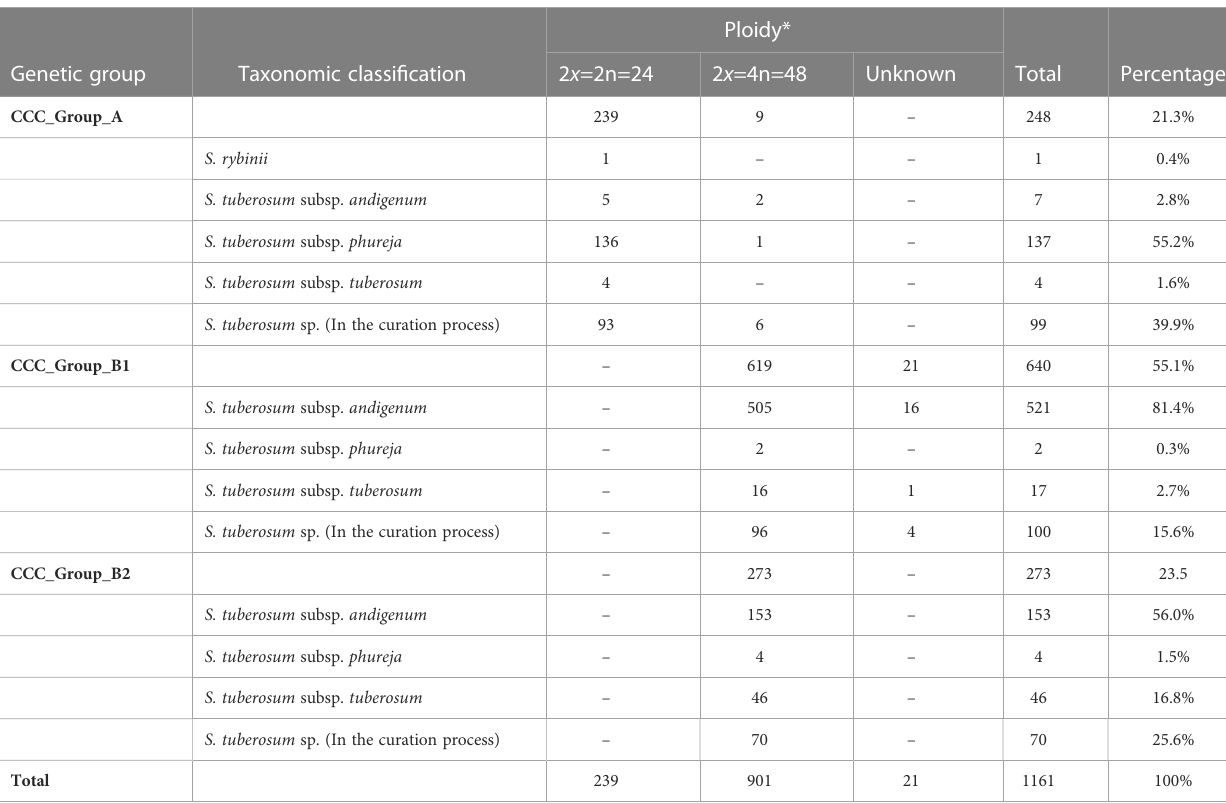
TABLE 2 Taxonomic and ploidy characteristics of three genetic groups identi fi ed in the Colombian Central Collection (CCC) of potatoes, based on population structure and genetic diversity analyzes.